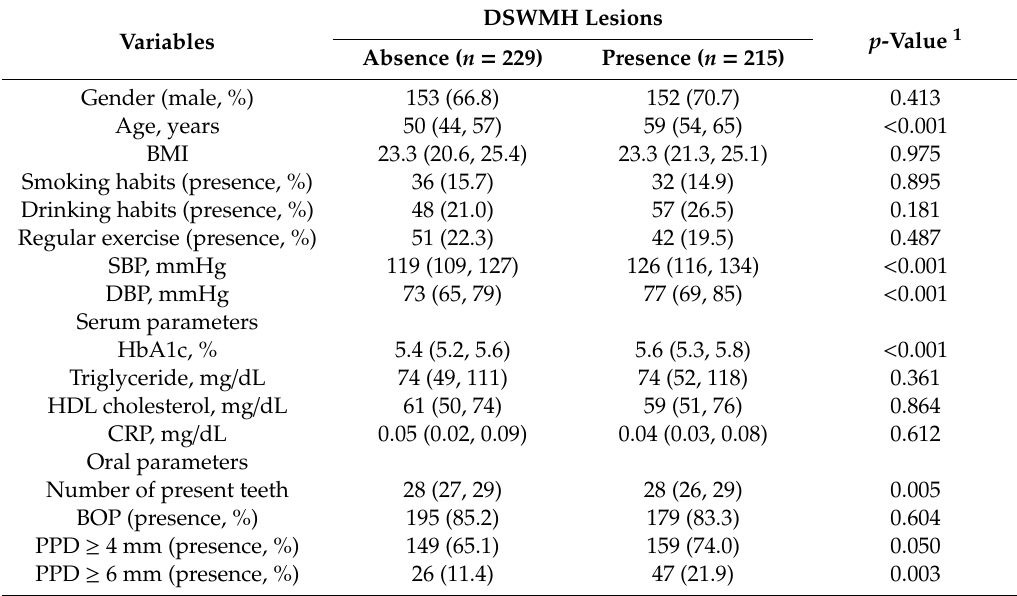
Table 1. Characteristics of study participants with and without DSWMH lesions.